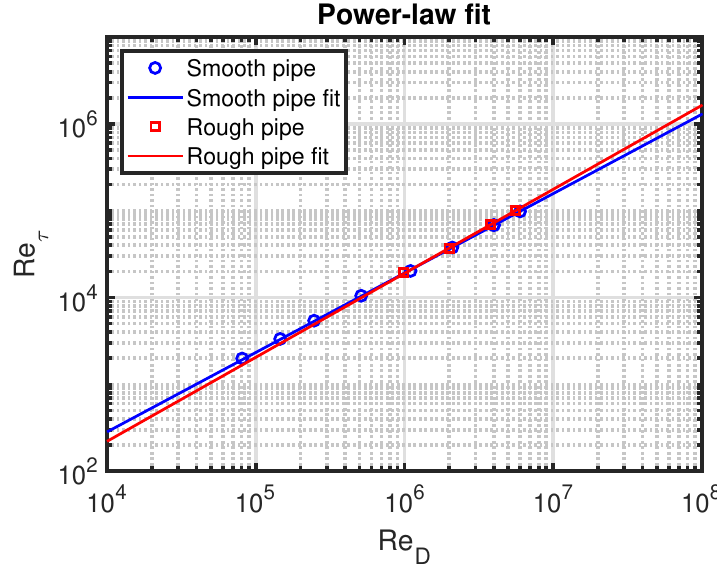
Figure 6. Relationship between Re D and Re τ . Table 5. Bulk and friction Reynolds number